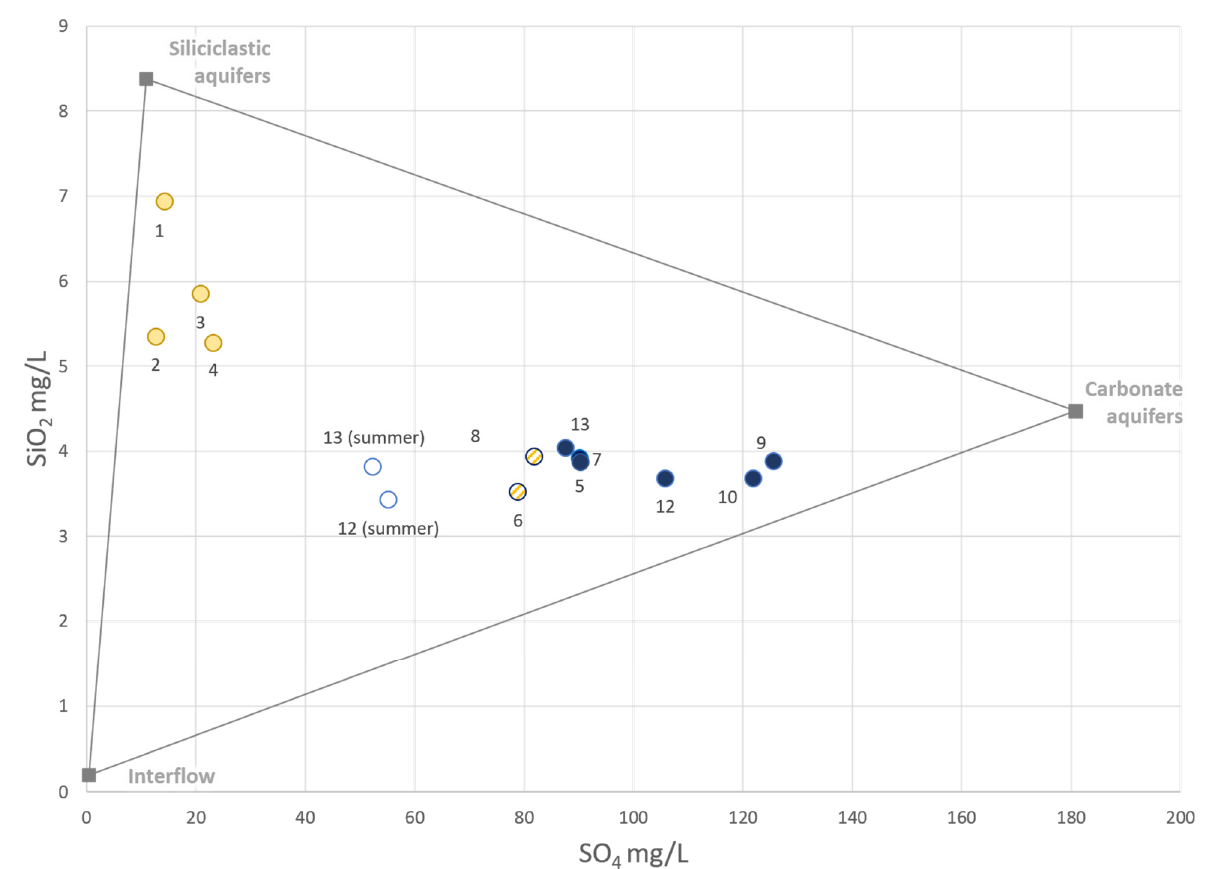
Figure 5. Silica–sulfate concentration cross plot illustrating the position of the samples collected in the current study within the three end-member mixing model previously developed for the Upper Elbow Watershed (from Campbell et al. [16]). Little Elbow Valley samples (yellow circles, points 1–4) plot toward the upper part of the siliciclastic-interflow mixing line. Samples from the transition area (hatched yellow circles, points 6 and 8) plot centrally but slightly toward carbonate end-member, and main Little Elbow River samples (blue circles, points 5, 7, 9–13) plot toward the carbonate aquifer source. Open blue circles are previously published data at points 13 and 14 from Campbell et al. [16].